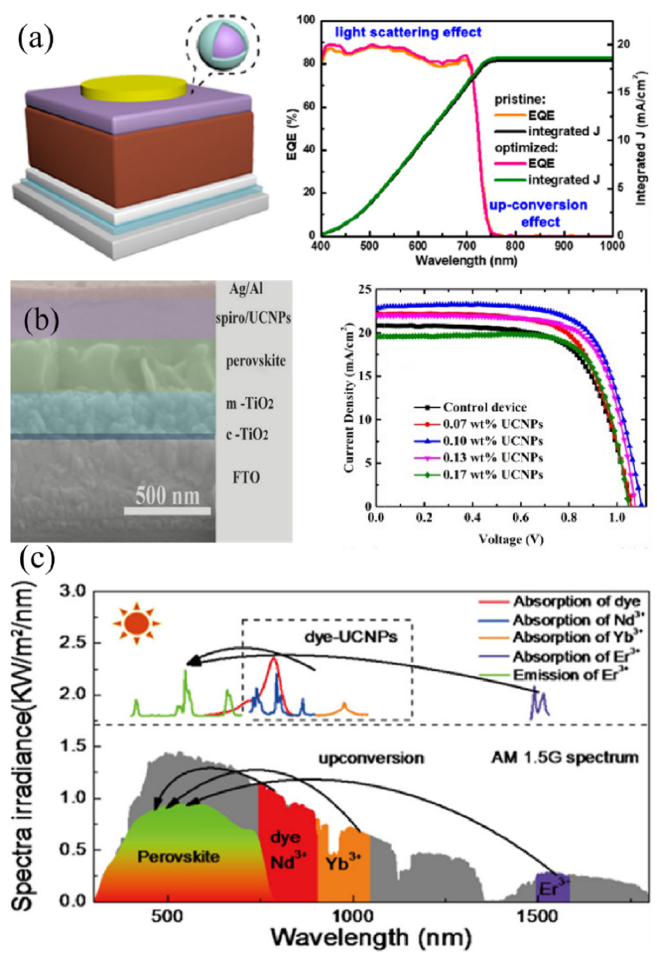
Figure 3. ( a ) Schematic device structure and external quantum efficiency curves of FTO/TiO 2 / γ - CsPbI 3 /NaLuF 4 :Yb,Er@NaLuF 4 UCNPs-doped PTAA/Au (Reprinted/adapted with permission from